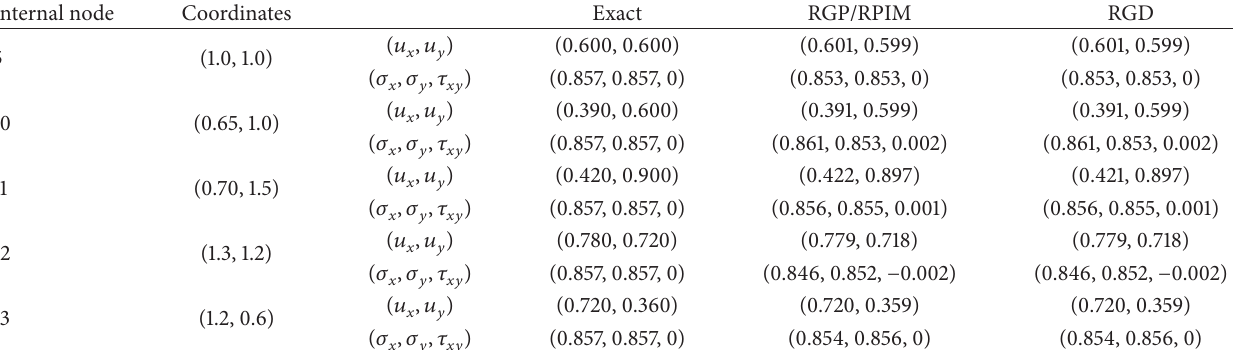
Table 1: Results at interior nodes located irregularly in the 13 nodes’ patch.